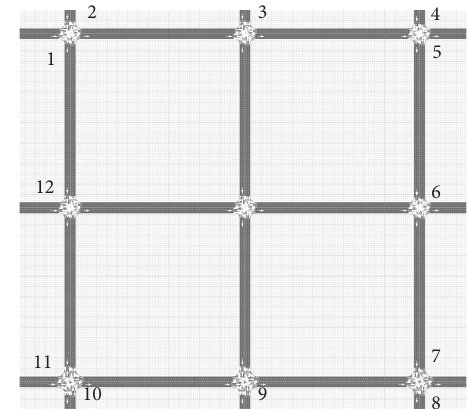
Figure 1: Hypothetic MFD